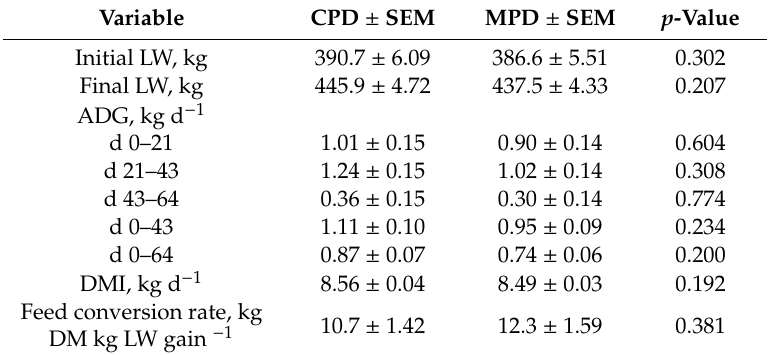
Table 3. Least square means for live weight, dry matter consumption, feed conversion, and daily weight gain per diet.